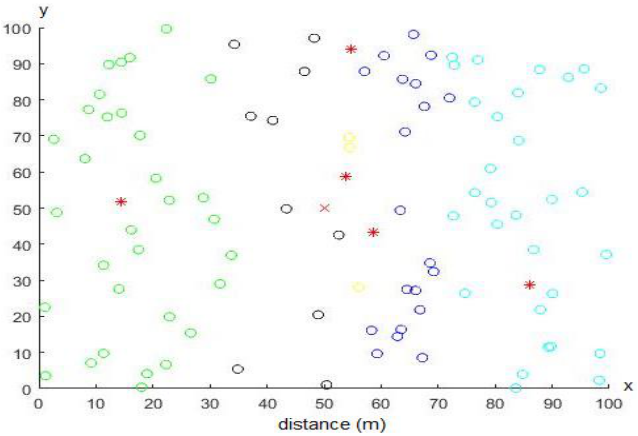
Figure15. AnexampleofLEACHnetworktopologywithanareaofinterest(AoI)equalsto100 × 100 m 2 . Figure 15. An example of LEACH network topology with an area of interest (AoI) equals to 100 × 100 m 2 .